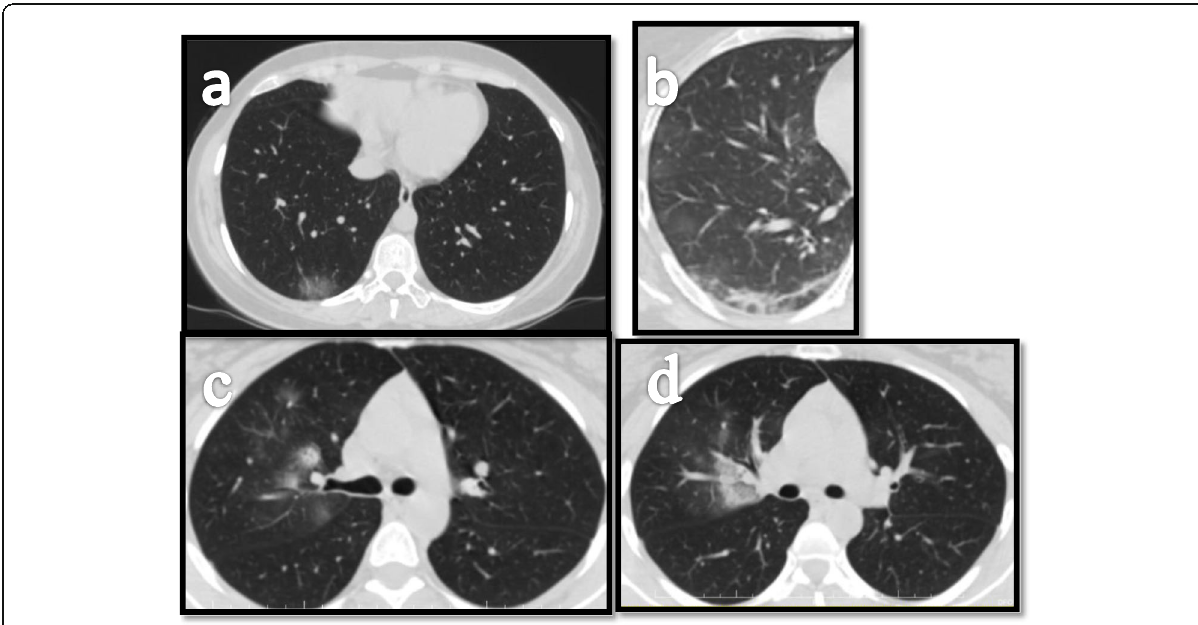
Fig. 2 A group of asymptomatic patients showing different radiological chest CT findings denoting early COVID. a Single subpleural basal pure GGO. b Subpleural curvilinear atelectasis. c Nodular consolidation with surrounding ground-glass veiling giving halo sign. d Fissural-based ground-glass opacity showing coarse interstitium